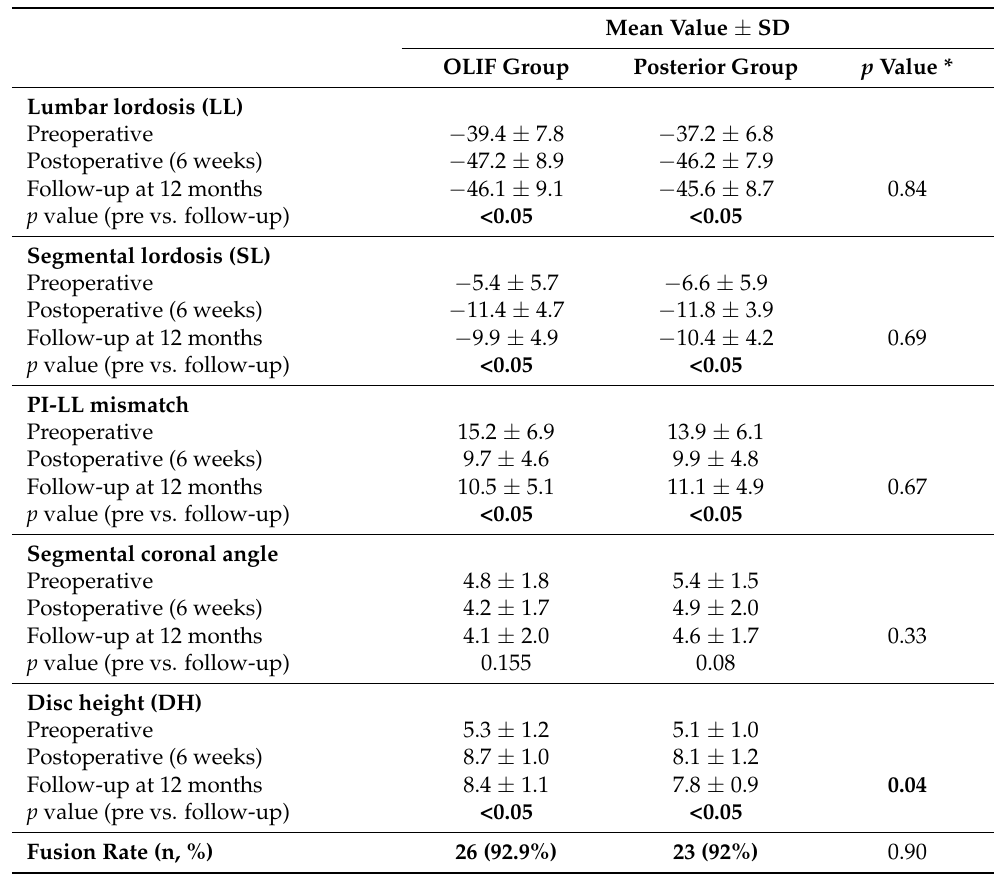
Table 4. Radiological outcomes.